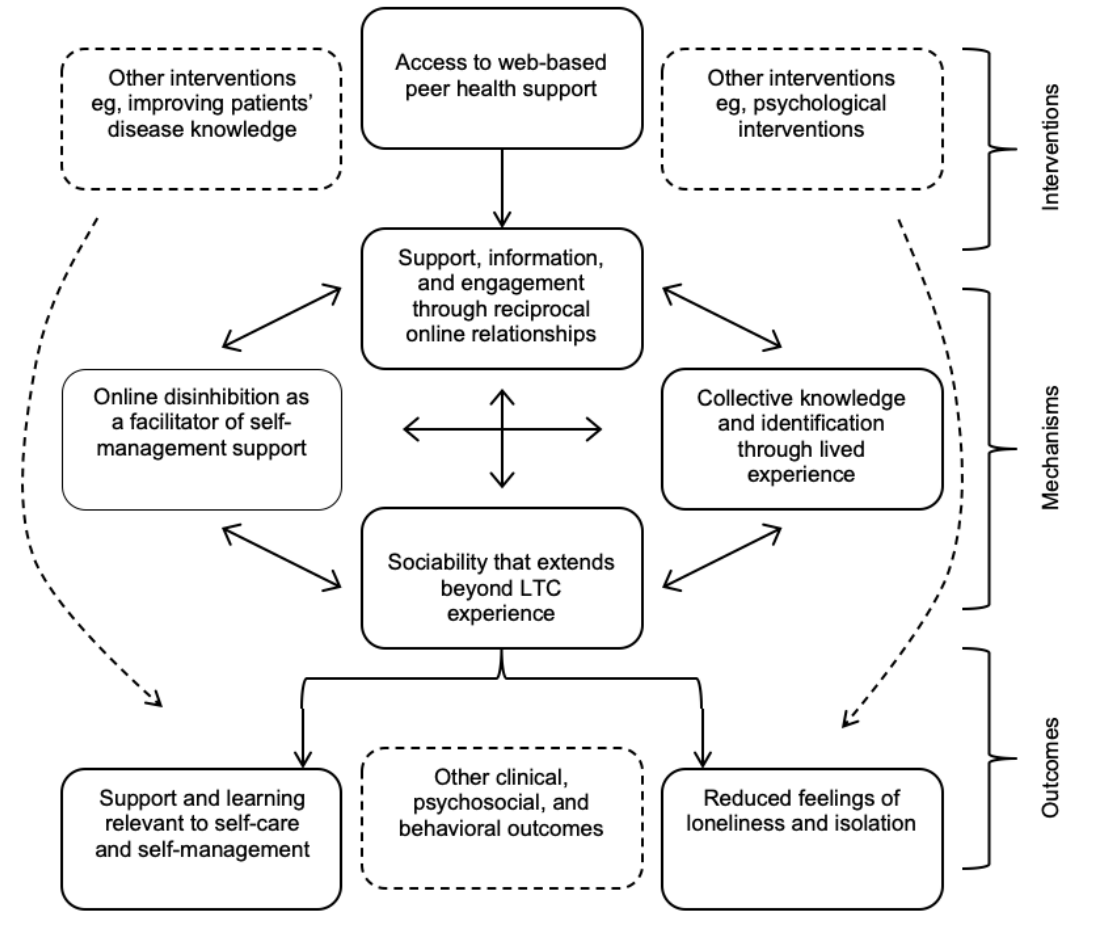
Figure 1. Theoretical model of pathways (logic model). LTC: long-term